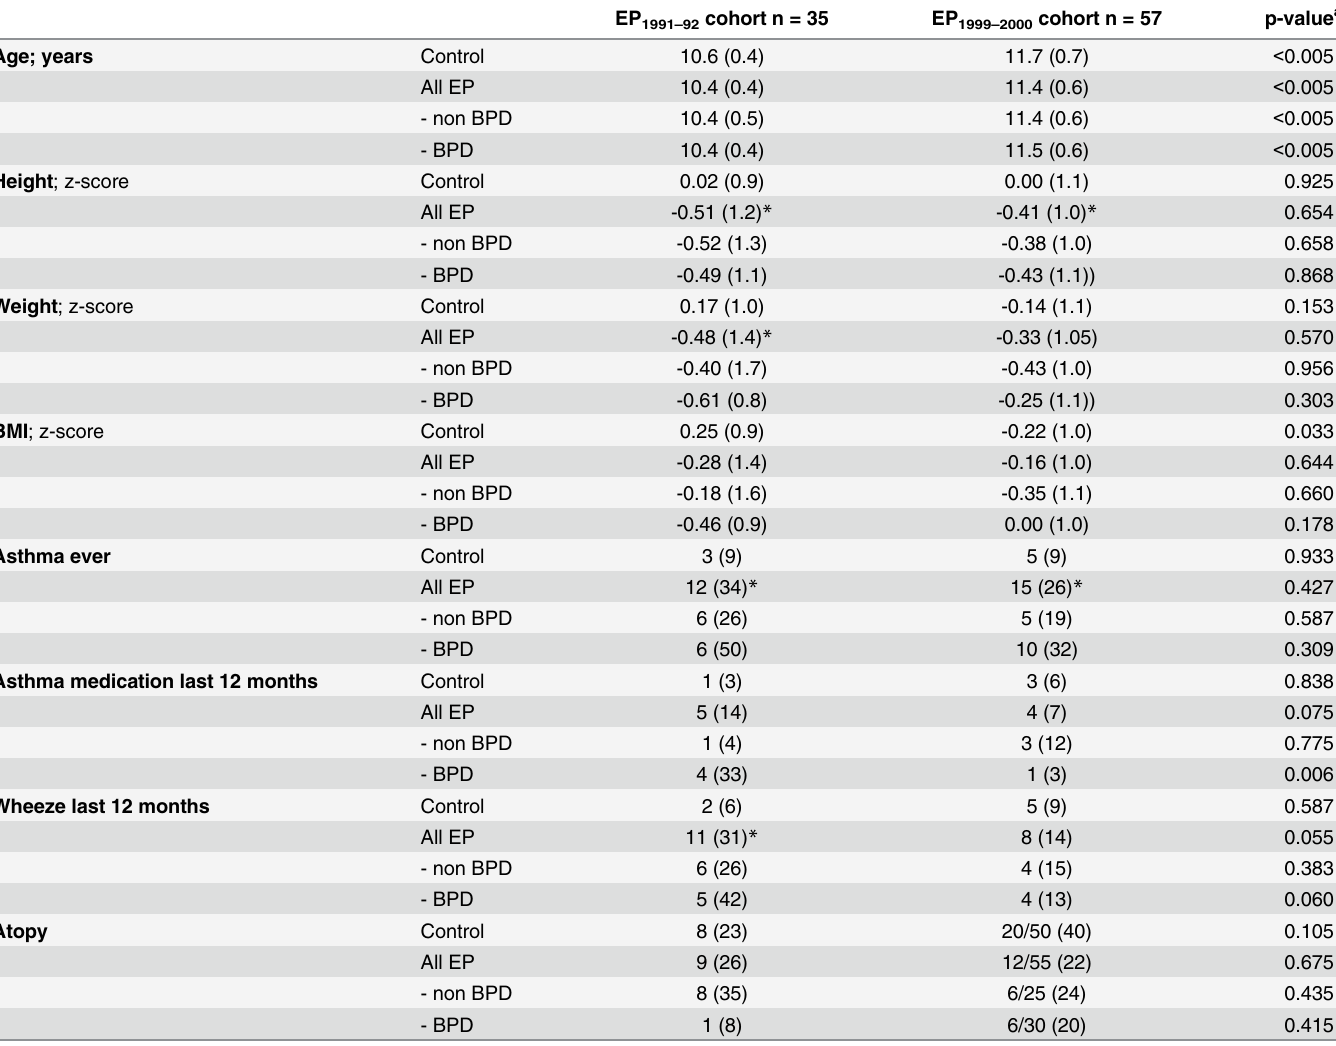
Table 2. Anthropometric data and respiratory symptoms at age 11 comparing children born preterm in 1991 – 92 (EP 1991 – 92 ) and in 1999 – 2000 (EP 1999 – 2000